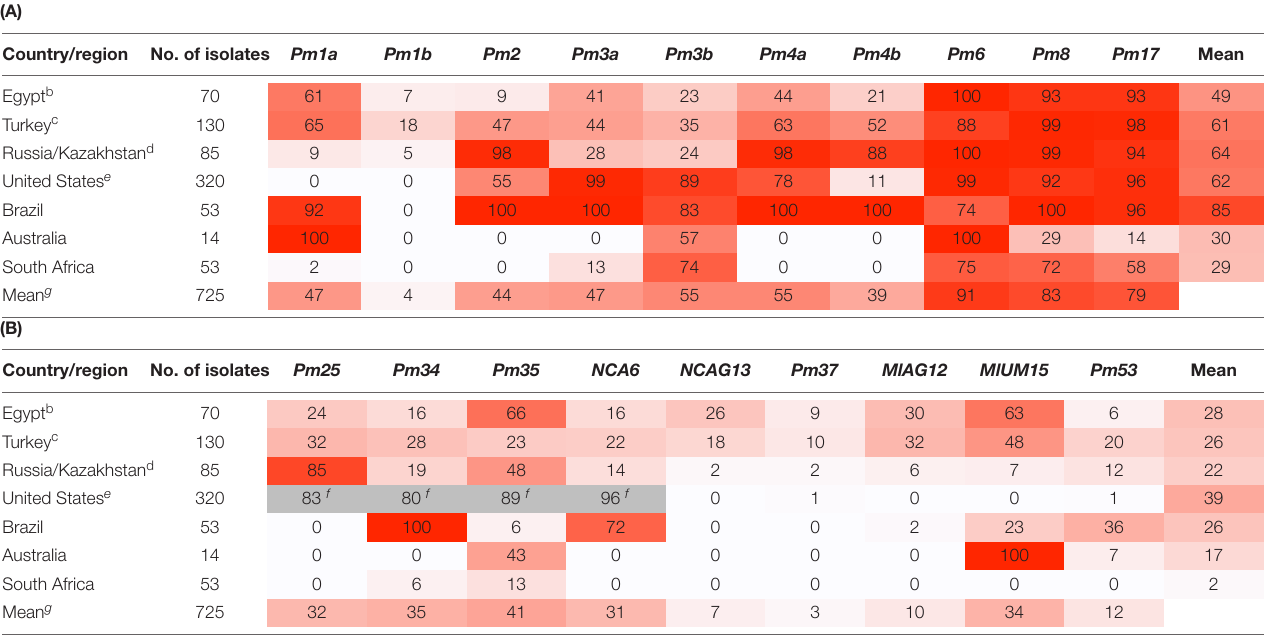
a For each country or region, virulence frequency was calculated as the percentage of isolates virulent to a Pm gene. Color gradient indicates low (white) and high (red) virulence frequency. b Abdelrhim et al. (2018). c Turkey/Black Sea region: Isolates from Russian locations Krasnodar and Rostov were grouped with those from Turkey (refer to Table 1 ). d Western Siberia region: Isolates from Karabalyk, Kazakhstan were grouped with those from Russia (refer to Table 1 ). e Cowger et al.